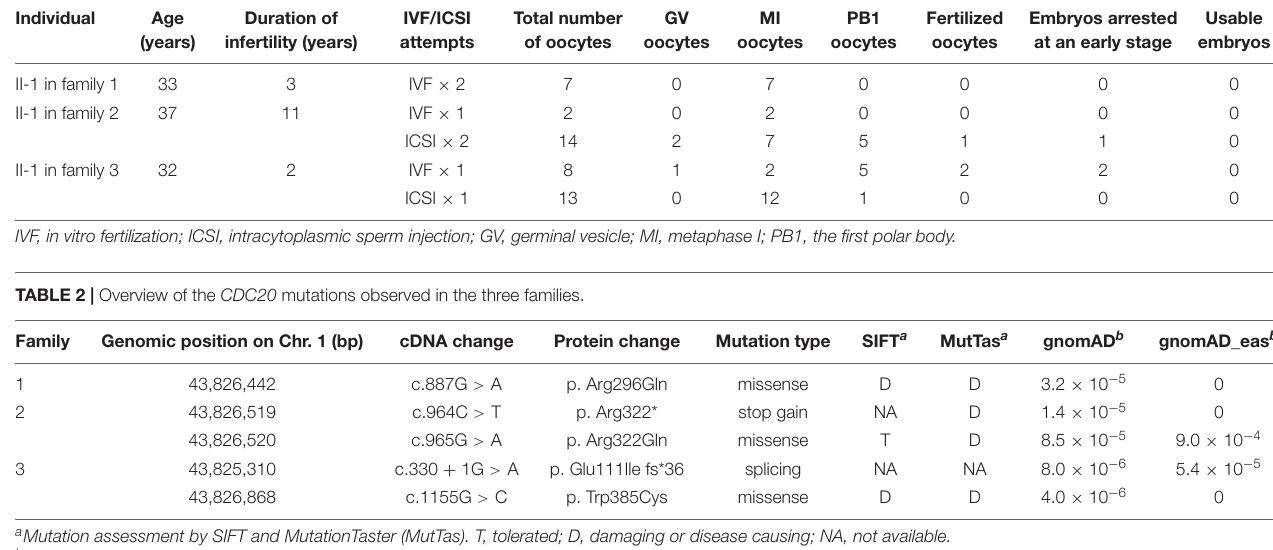
Embryos arrested Usable at an early stage embryos